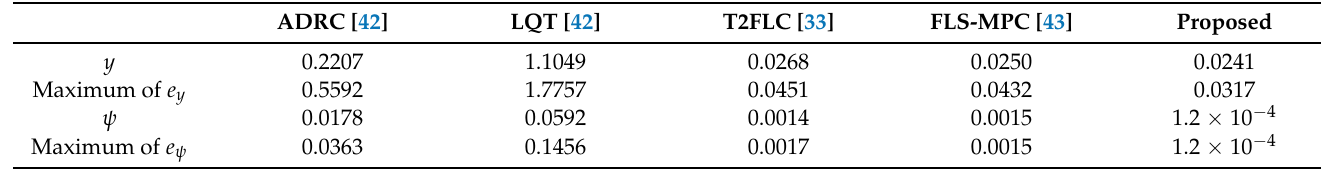
Table 2. Comparison of RMS and tracking error peak values.